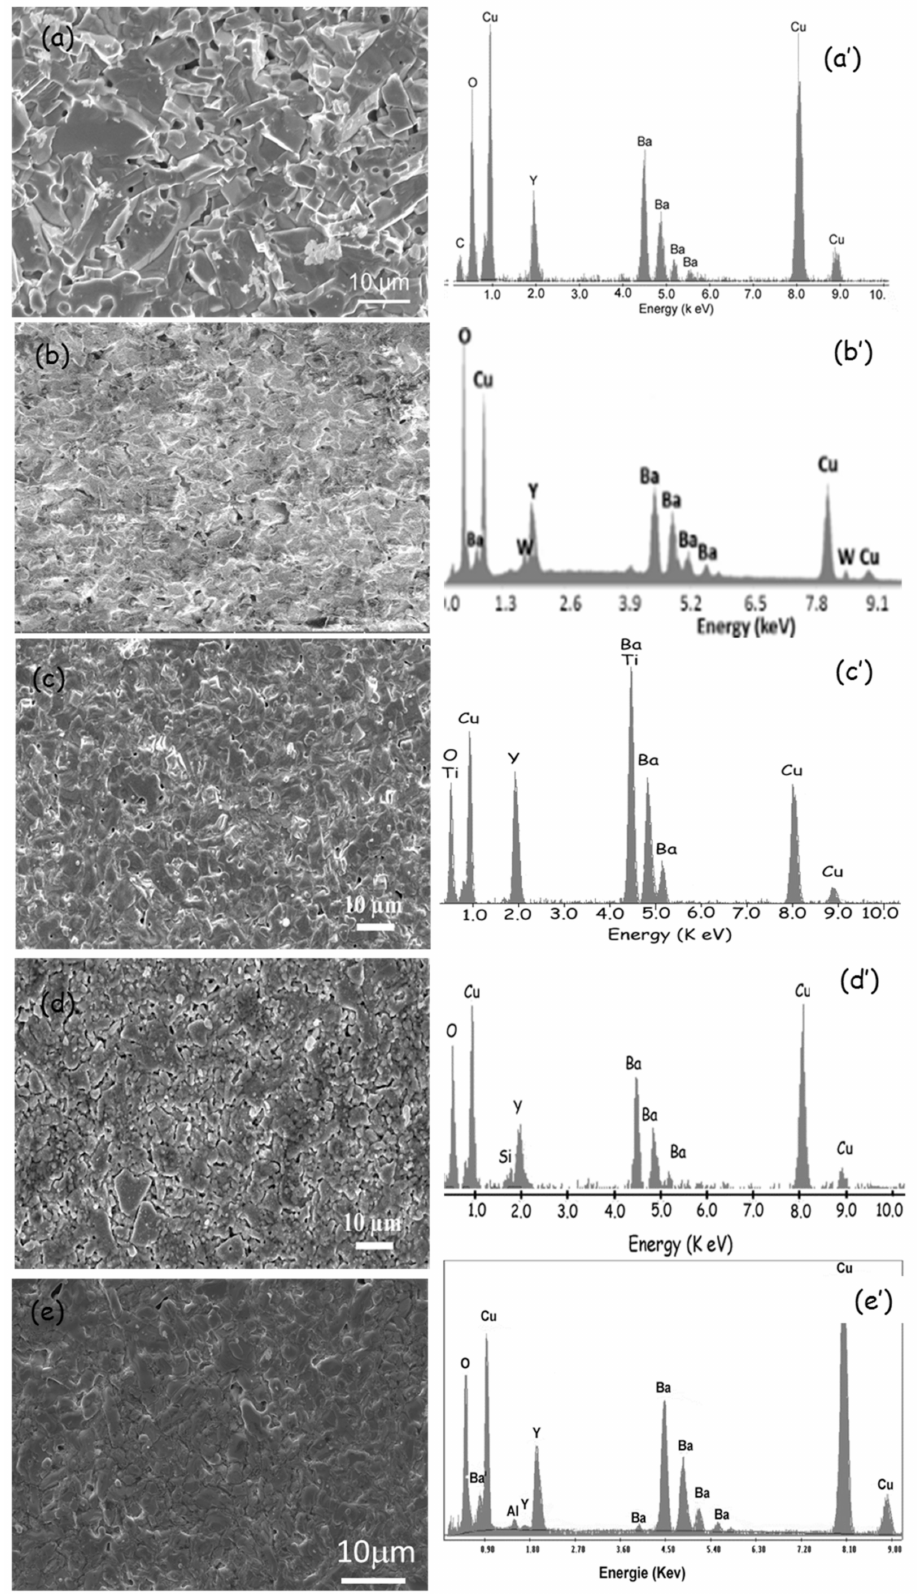
Figure 5. SEM images and EDX analysis for ( a,a’ ) YBCO, ( b,b’ ) YBCO-W, ( c,c’ ) YBCO-Ti, ( d,d’ ) YBCO- Si, and ( e,e’ )